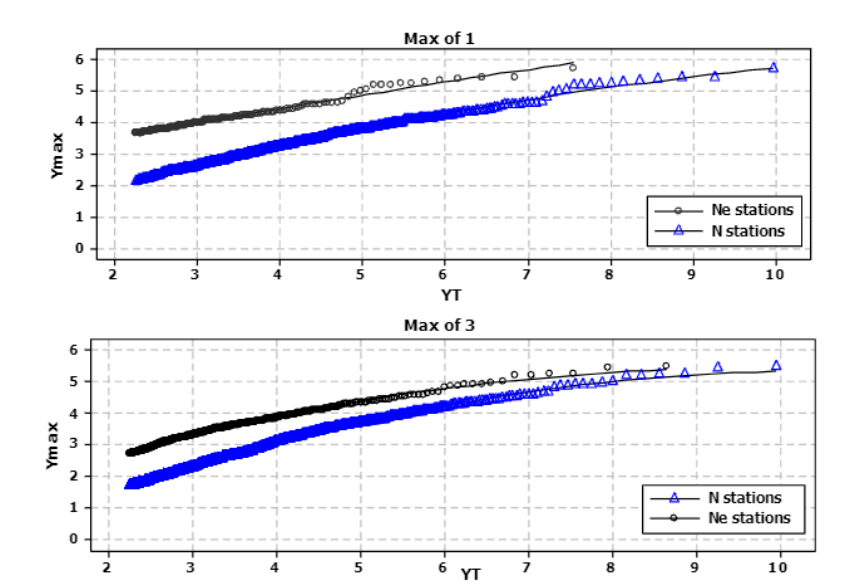
Figure 6. Frequency distribution of standardised Y max values using N and N e stations. (Top panel) Maxima 1; (bottom panel) Maxima